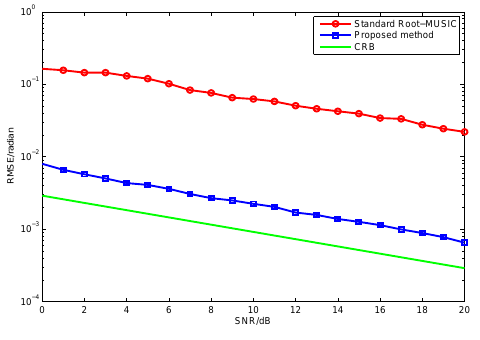
Figure 5. RMSE of γ estimates versus SNR with snapshot number 1000.